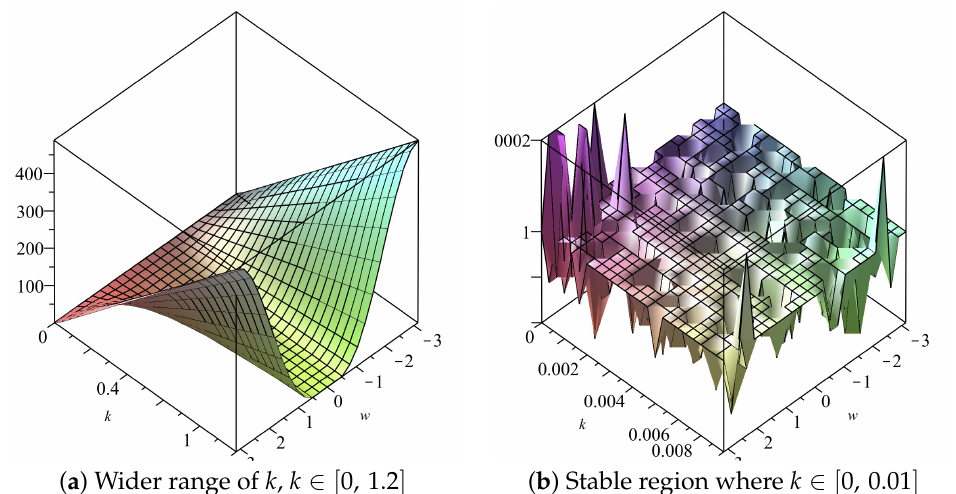
Figure 7. Plot of | ξ 2 | vs. k vs. w ∈ [ − π , π ] of Scheme 2 for Numerical Experiment 1. The spatial step size h = π